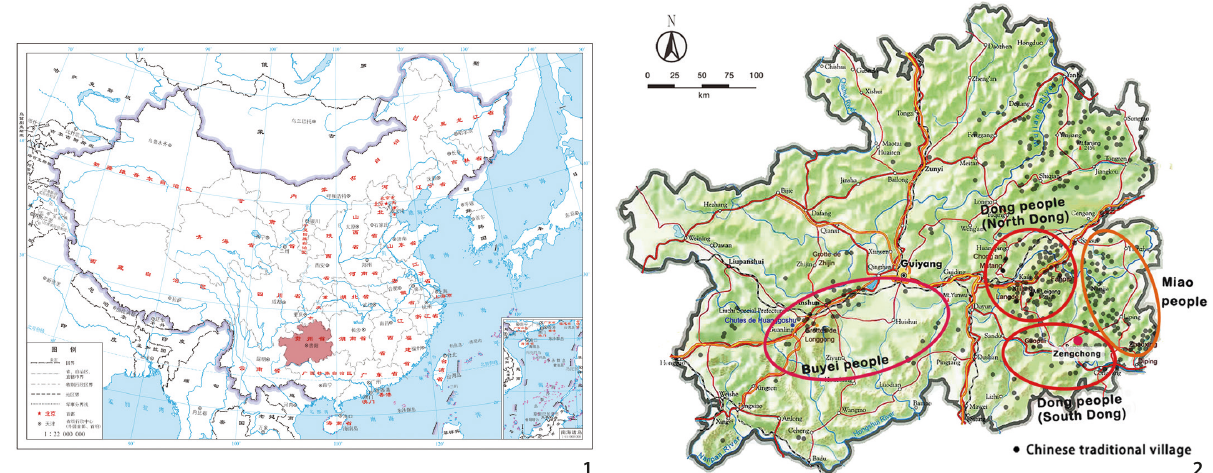
Figure 1 Location of Guizhou Province (Source: National Bureau of Surveying and Mapping Geographic Information, map approval code: GS[2016]2883). Figure 2 Distribution of Miao, Dong and Buyei Minorities in Guizhou Province (Source: the